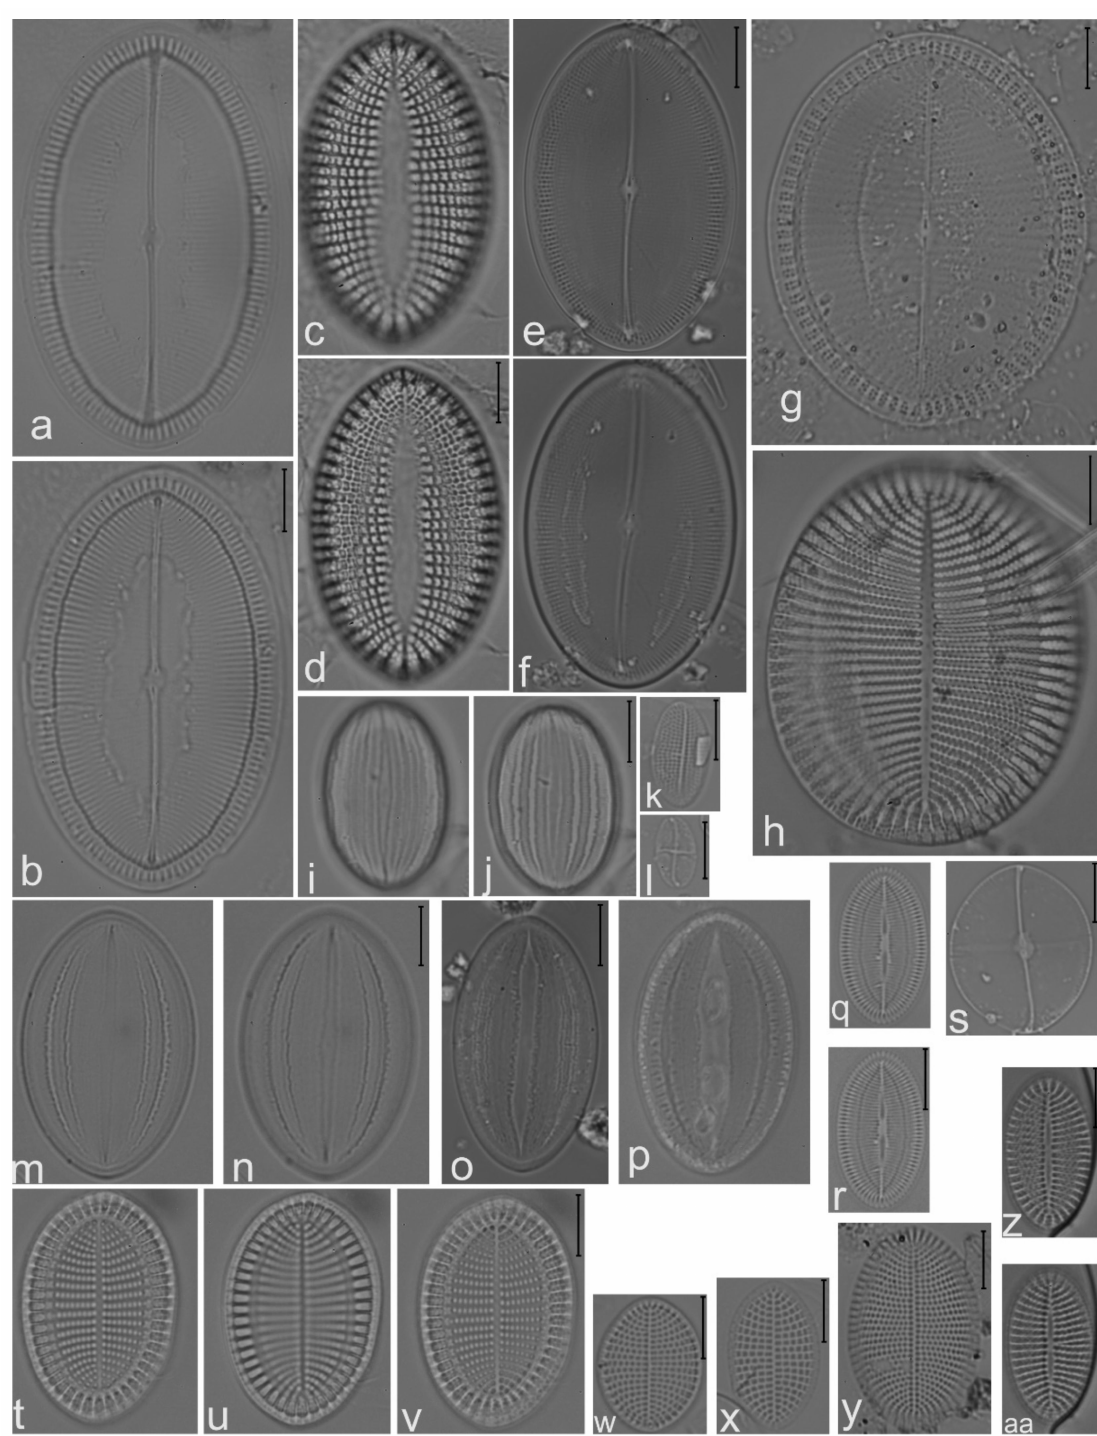
Figure 13. ( a – d ) Cocconeis maxima ; ( e , f , m – p ) C . krammeri ; ( g , h ) C . thalassiana ; ( i , j ) C . pellucida var. sigmoidea ; ( k , l ) C . diruptoides ; ( q , r , z , aa ) C. comis ; ( s ) C . decipiens ; ( t – v ) C . britannica ; ( w ) C . scutellum var. parva ; ( x ) C . speciosa ; ( y ) C . scutellum var. scutellum . Scale bar = 10 µ